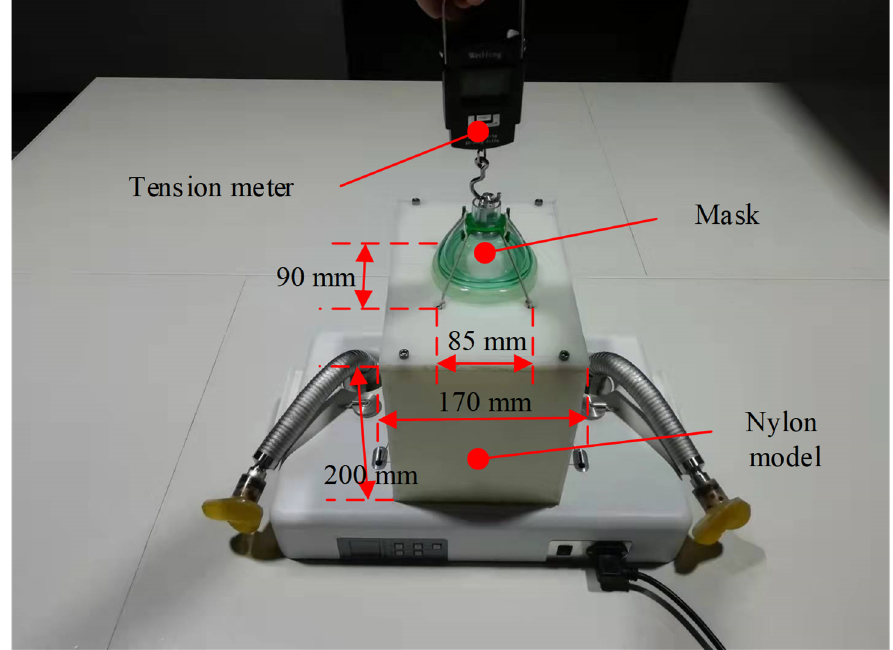
Figure 11. The platform for the tension test of the mask-fastening module.